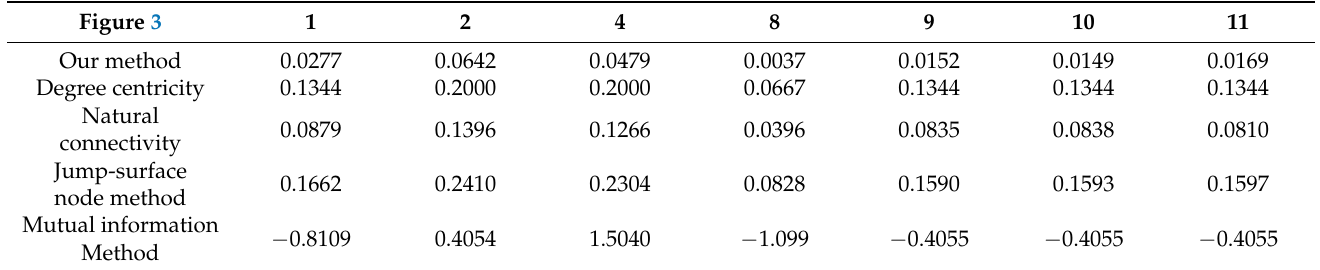
Table 5. Calculation results of node importance in Figure